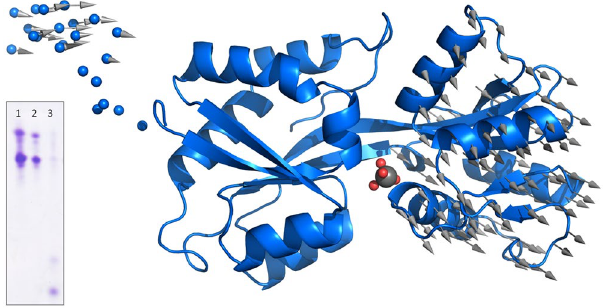
Figure 5. Three-dimensional coordinates for the holo-form hybrid model are displayed using a cartoon representation. The N-terminal section modeled with BUNCH is shown as small spheres. The large gray sphere in the center corresponds to the tungstate group (small red spheres represent O atoms) modeled by homology with PDB entry 3cfz and 3lr1. Vectors have been drawn connecting C α s from the holo-form model to the apo- form model generated by SREFLEX, after superposition of lobe A, to display the ‘opening’ conformational transition. Upon optimal superposition including all C α (274), the RMSD is 1.5 Å. Insert: Urea-polyacrylamide gel electrophoresis of (1) TupA, (2) TupA + MoO 4 , (3) TupA + WO 4 . The samples in presence of ligand were first passed through a size exclusion PD-10 minitrap G-25 columns to eliminate the